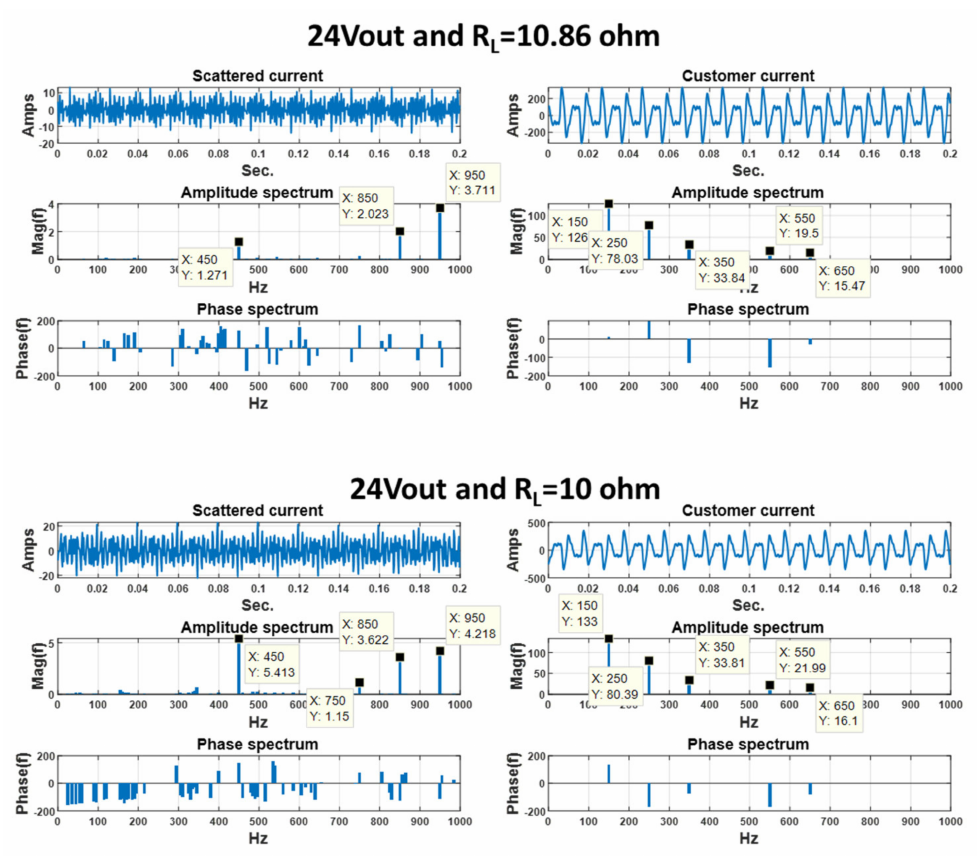
Figure 21. Loaded AC/DC converter: differences observed in CPC physical components at the same voltage and different output